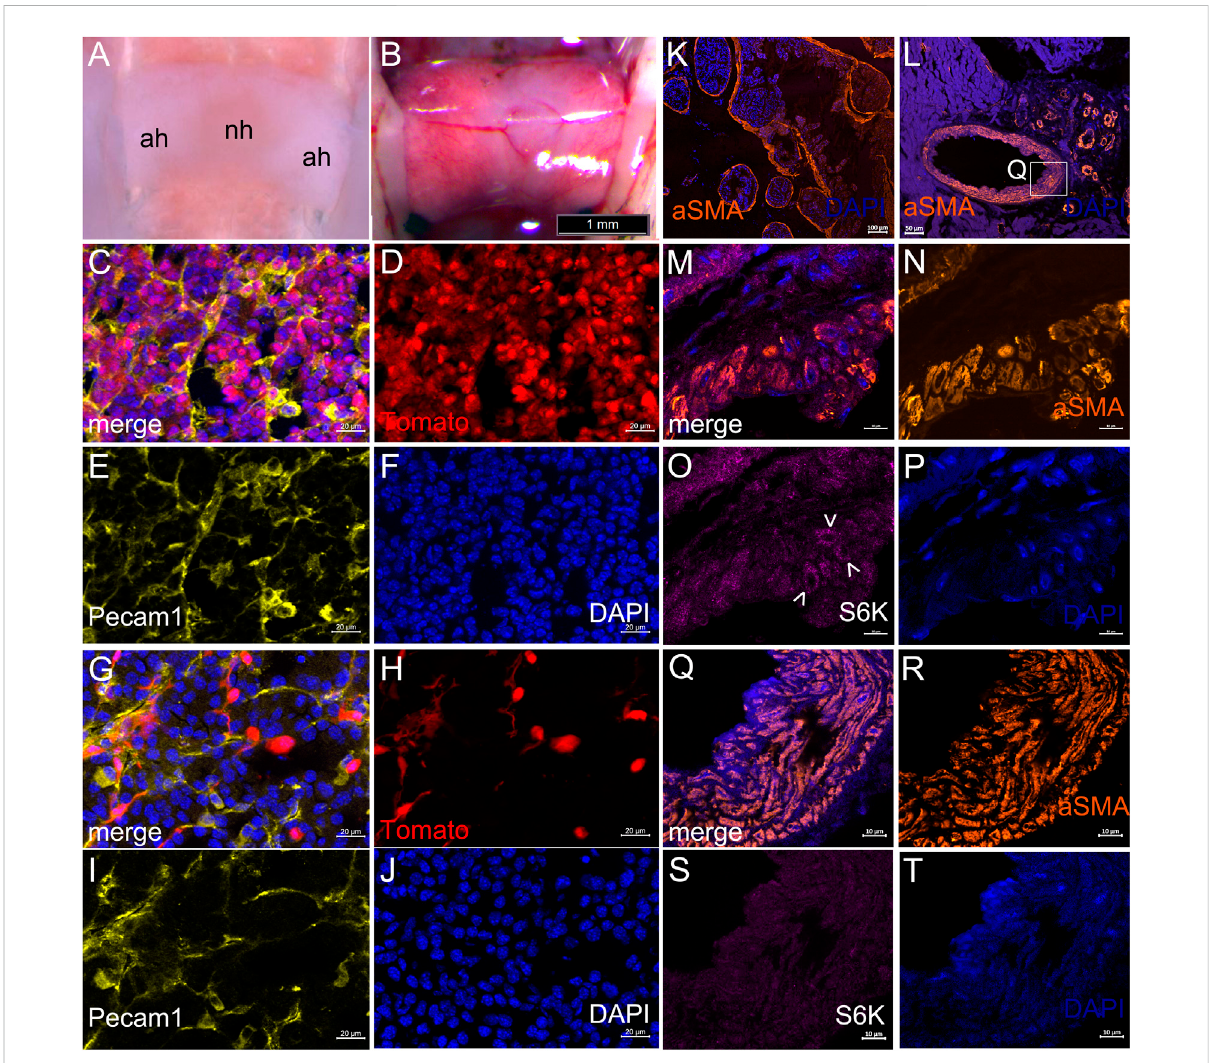
Lineage tracing and immuno fl uorescence in Krox20-Cre +/ ° ; Pik3ca H1047R/+ adult mutant mice. (A) Dorsal view of control pituitary after removal of brain and meninges. (B) Dorsal view of Krox20-Cre +/ ° ; RdT +/ ° pituitary during dissection after removal of brain, showing highly fl uorescent adenohypophysis under visible light. Bar, 1 mm. (C – F) Section through adenohypophysis of Krox20-Cre +/ ° ; RdT +/ ° mouse, showing normal cell density and that most or all cell types, including perivascular nuclei, had expressed Krox20 , unlike the sparse recombination observed in the neurohypophysis(notshown)(C)Merged(D)Tomato(E)Pecam1(CD31)(F)DAPI fl uorescence.Bar,20 µm. (G – J) Sectionthroughadenohypophysis of Krox20-Cre +/ ° ; Pik3ca H1047R/+ ; RdT +/ ° mouse,showingreducedcelldensityaccompaniedbyastrikingreductionincellsthathadexpressed